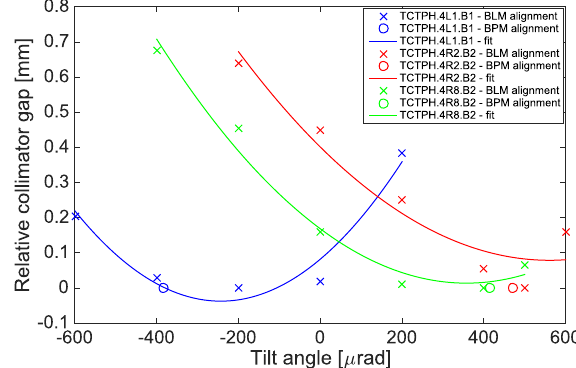
FIG. 8. Measurements of tilts in three collimators from BPM- based and BLM-based alignment.